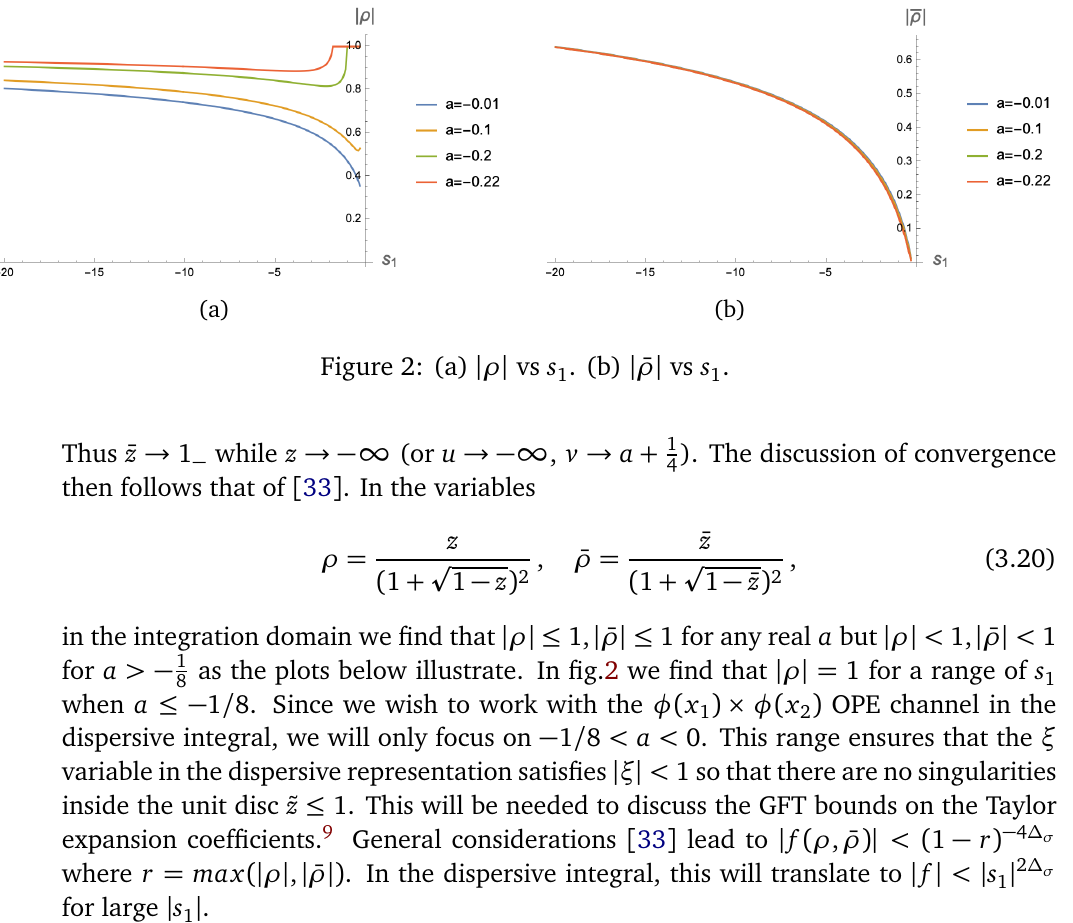
Figure 2: (a) | ρ | vs s